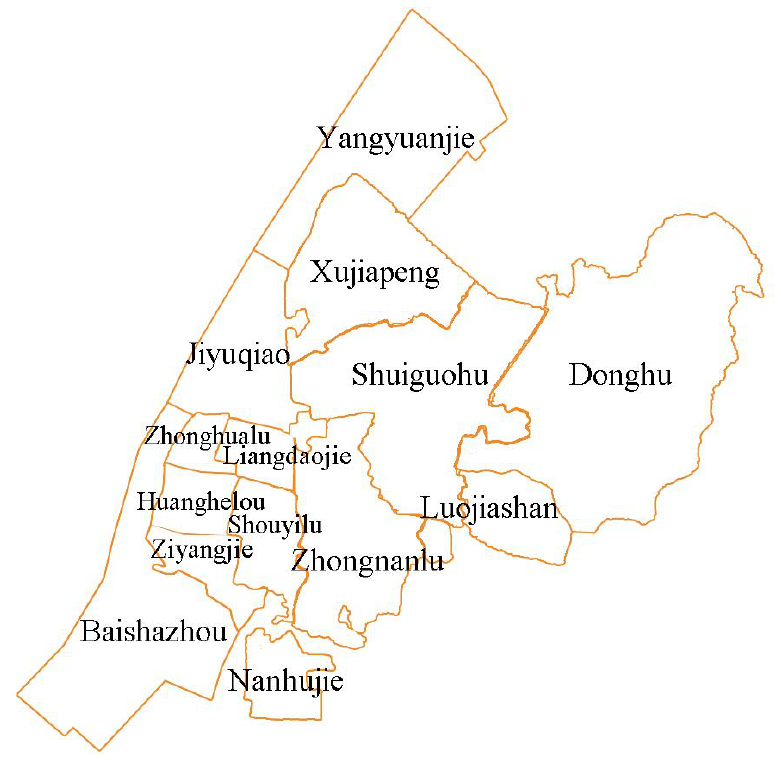
Figure 1. Schematic diagram of the administrative boundary of Wuchang District.